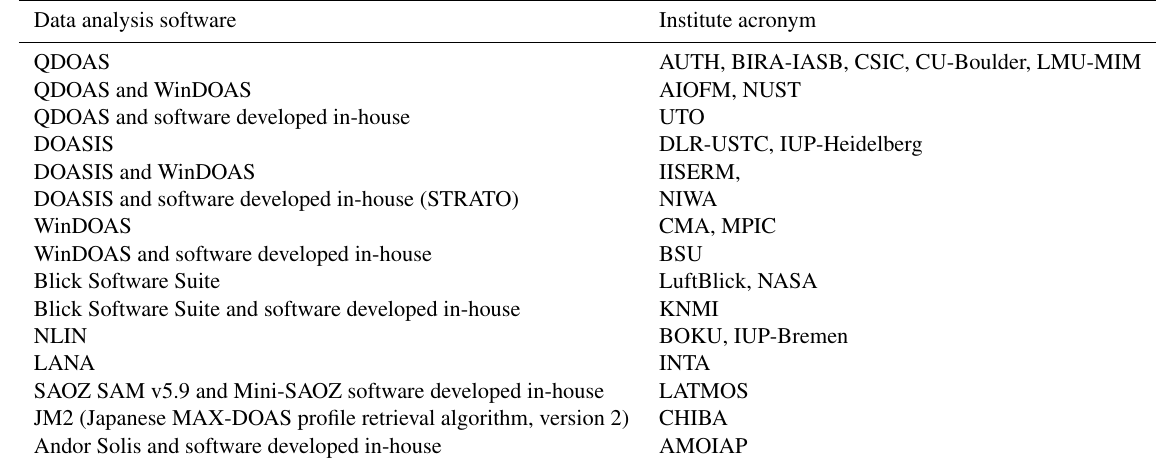
Table 3. Overview of analysis software used by each of the participating institutes. Data analysis software